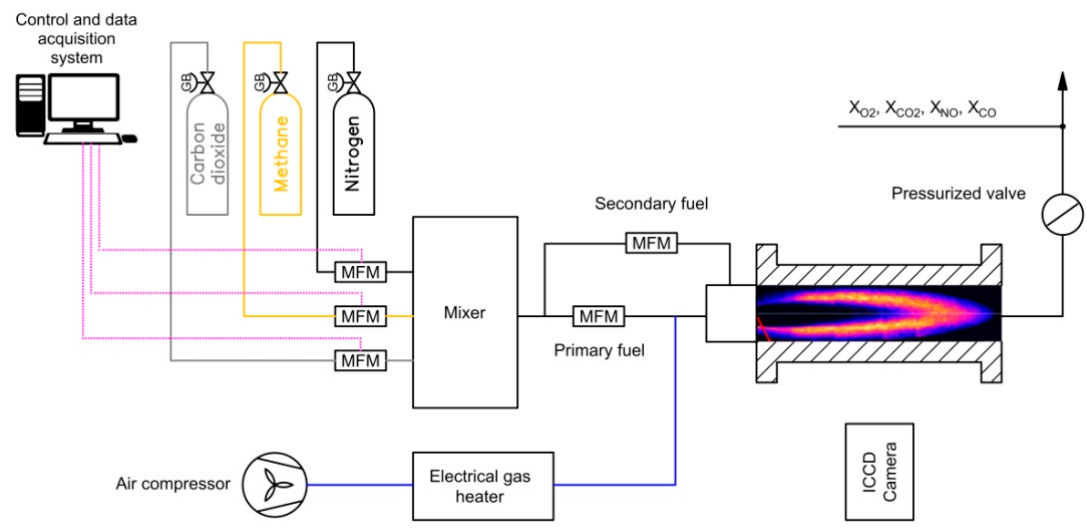
Figure 1. Scheme of test setup.